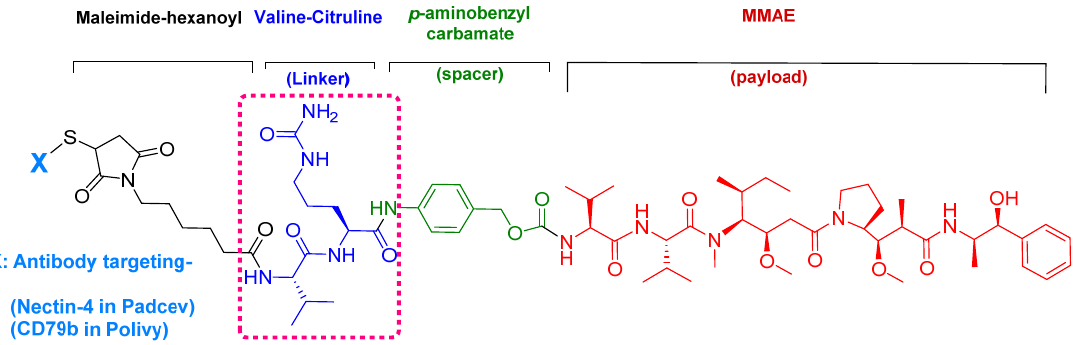
Figure 7. Chemical structure of enfortumab vedotin-ejfv (Padcev TM ) and polatuzumab vedotin-piiq (Polivy TM ). MMAE; monomethyl auristatin E.